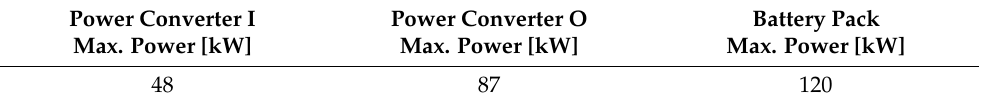
Table 5. Maximum power of battery and power converters of Chevrolet Volt derived from [37,39].